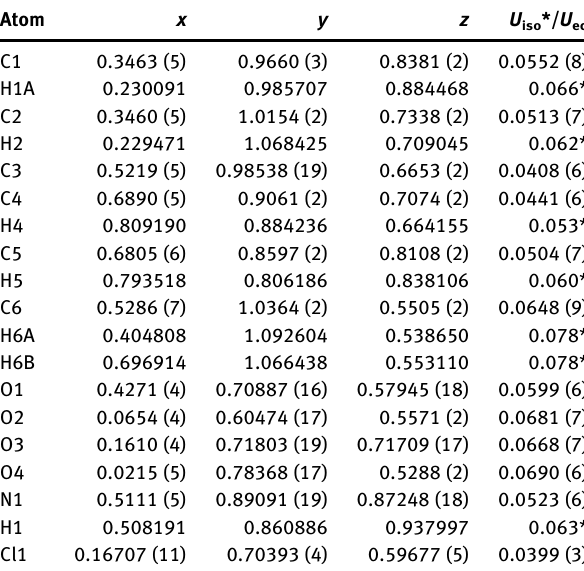
expanded along the b -axis in the previous polymorph [6], while, the hydrogen bonds in the title structure are weaker.